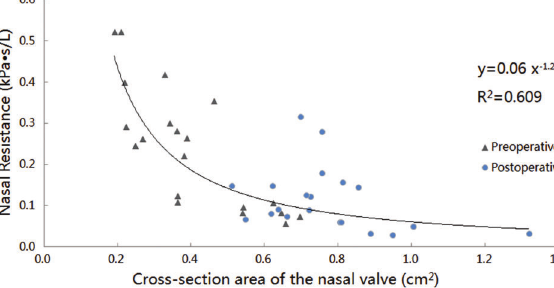
Figure 7. Pre- and postoperative unilateral nasal resistance vs. cross-sectional area at the nasal valve on the narrow side of nasal